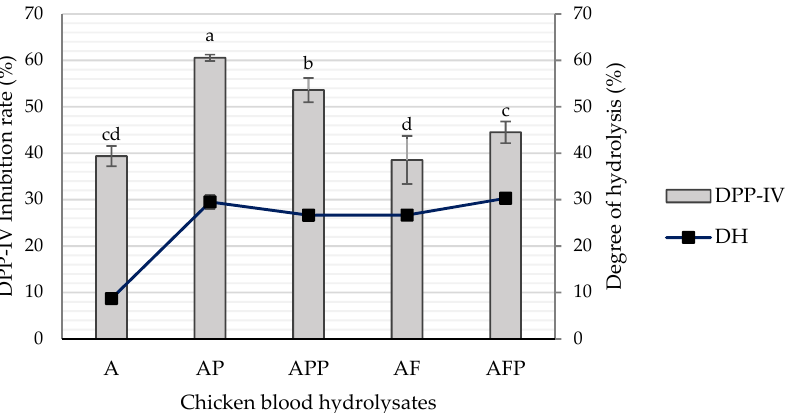
Figure 1. DPP-IV inhibition rate and degree of hydrolysis of different chicken blood hydrolysates: A) 2% Alcalase, AP) 2% Alcalase + 5% Protana Prime, APP) 2% Alcalase + 5% Protana Prime + 3% Protana UBoost, AF) 2% Alcalase + 1% Flavourzyme and AFP) 2% Alcalase + 1% Flavourzyme + 3% Protana UBoost. Bars with the same letter between samples are not statistically different. Tukey, p < 0.05.